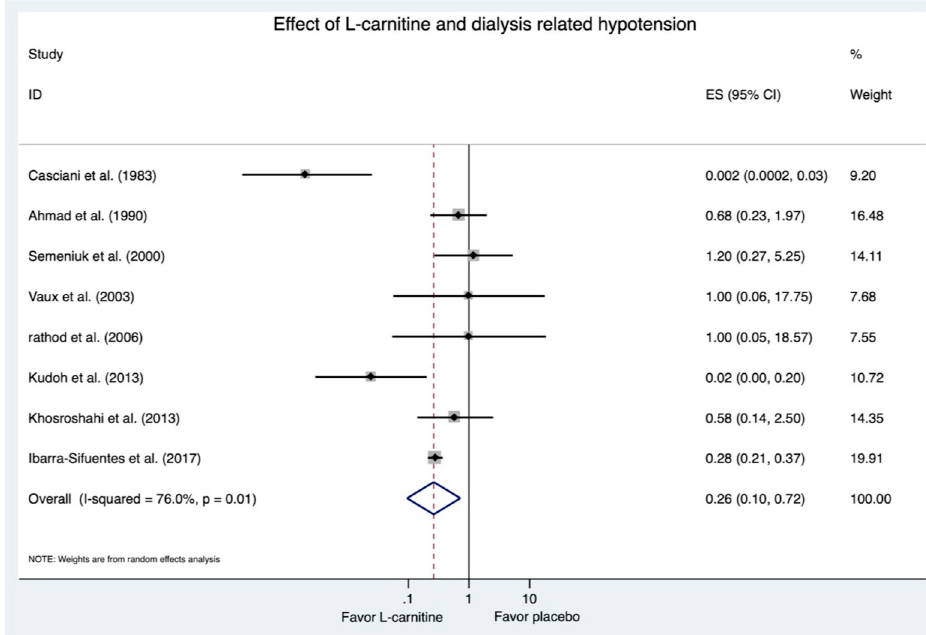
Fig 2. Forest plots of the included studies assessing odds ratio of dialysis-related